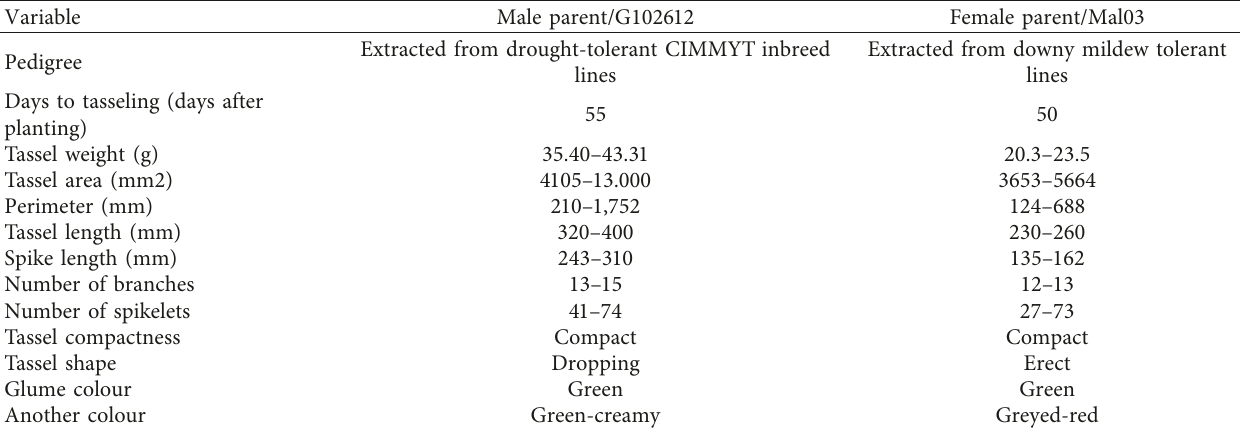
Table 2: Description of male and female parental lines used in the